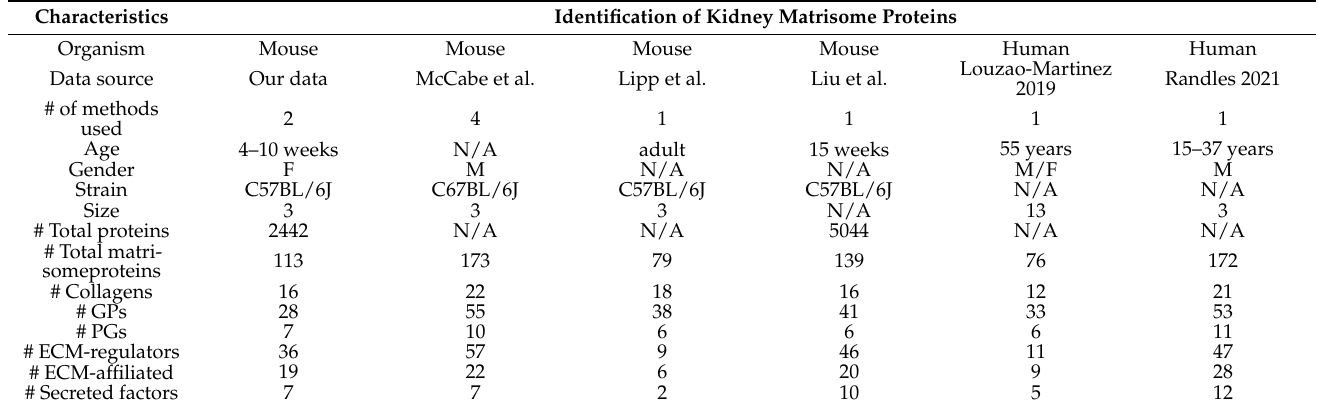
Table A9. The comparative analysis of the matrisome composition revealed in mouse and human kidney samples by different studies, including the current study, as well as publications by McCabe et al. [20], Lipp et al. [28], Liu et al. [30], Louzao-Martinez et al. [31], and Randles et al. [32].